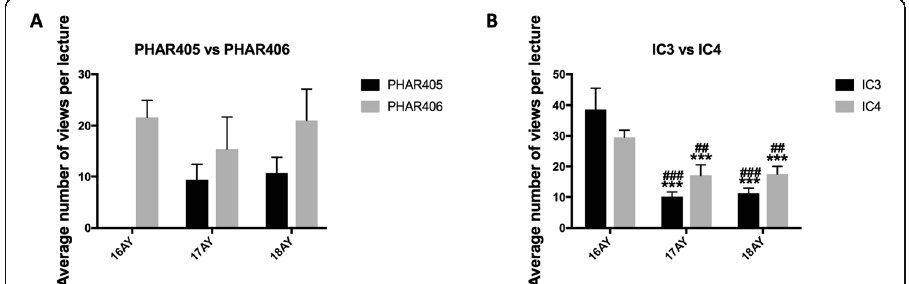
Fig. 3 Comparison of Fall and Spring semester courses delivered in series in Professional Year 3 over three academic years (16AY, 17AY and 18AY). Black bars indicate courses delivered in Fall and grey bars indicate courses delivered in Spring semesters. The bar charts represent the average number of views per lecture expressed as mean ± SEM. *** P < 0.001 versus IC3 (16AY); ## P < 0.01, ### P < 0.001 versus IC4